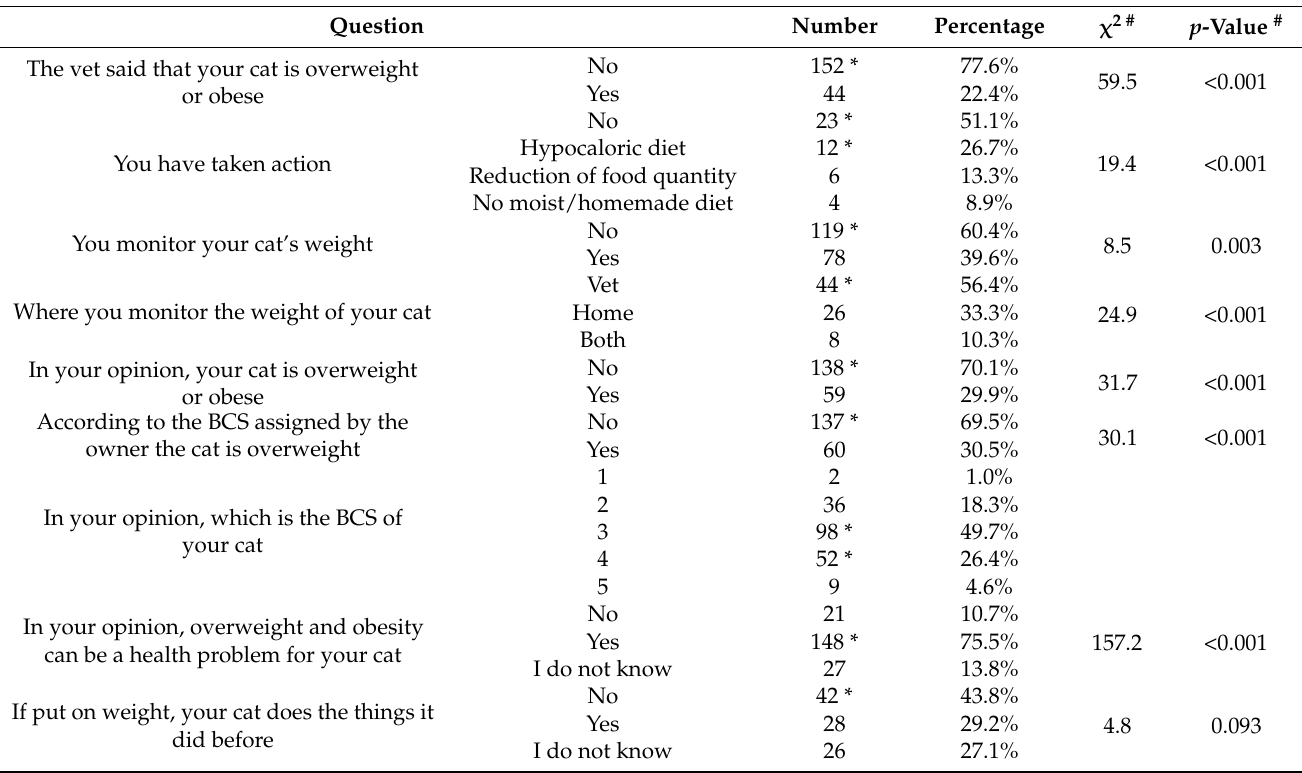
Table 1. Opinion of the owner about the weight of their